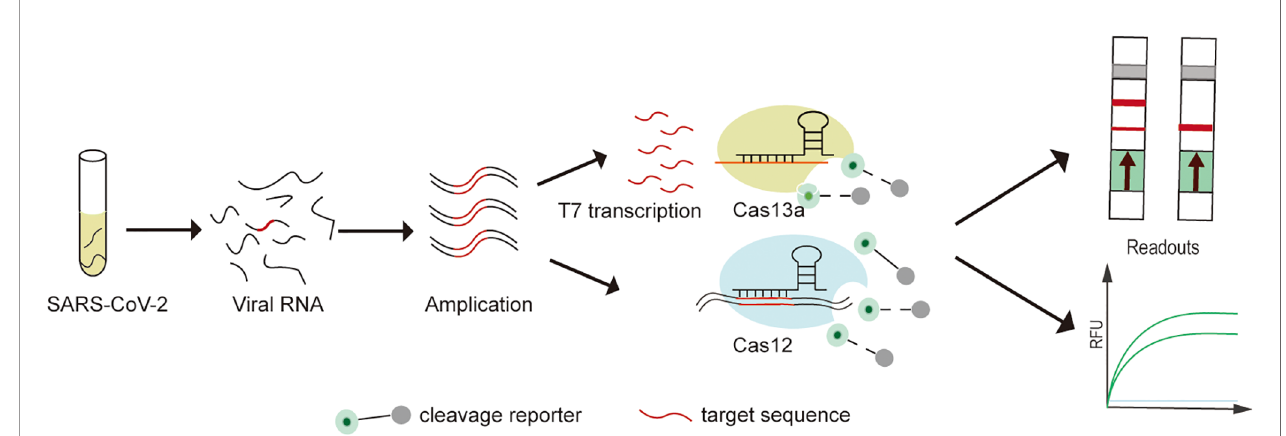
FIGURE 1 | Experimental protocol for SARS-CoV-2 detection on CRISPR/Cas detection platform. (1) The extracted SARS-CoV-2 viral RNA is fi rst pre-ampli fi ed (RT-RPA and RT-LAMP) into double-stranded DNA (dsDNA). (2) For Cas13a-SHERLOCK assay, dsDNA is fi rst T7 transcribed into single-stranded RNA (ssRNA), followed by activation of the Cas13a cleavage reporter. (3) For Cas12a or Cas12b assays, direct detection of pre-ampli fi ed dsDNA enables activation of the Cas12a or Cas12b cleavage reporter. (4) Visualization of CRISPR/Cas assay results by fl uorescence and lateral fl ow